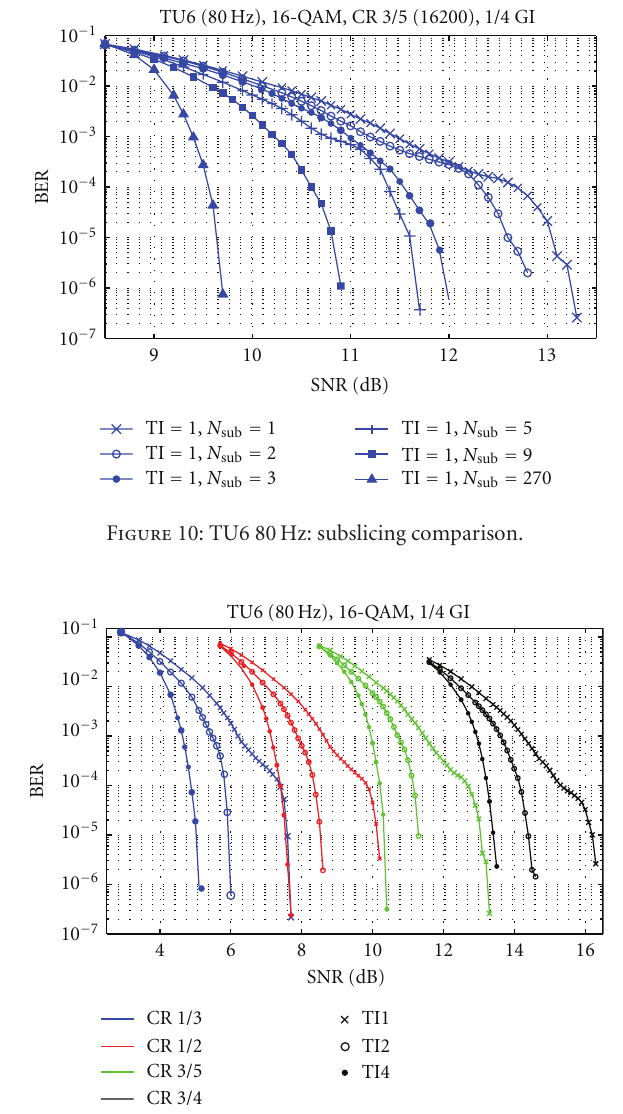
Figure 11: TU6 80 Hz: Code rate and time interleaving